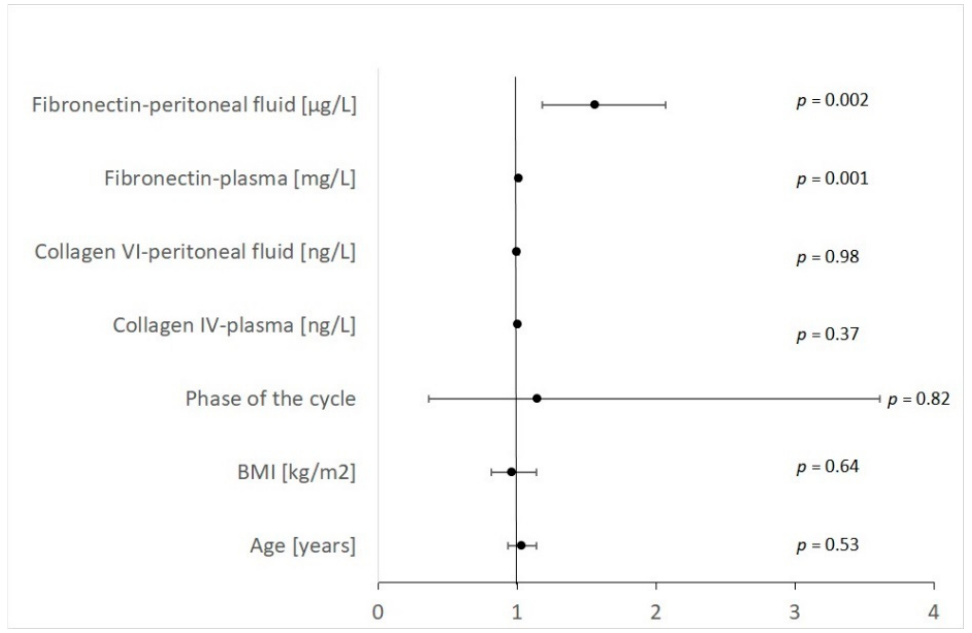
Figure 1. Logistic regression for endometriosis OR and 95% CI (n = 59). Table 4. Logistic regression for endometriosis OR and 95% CI (n = 59).